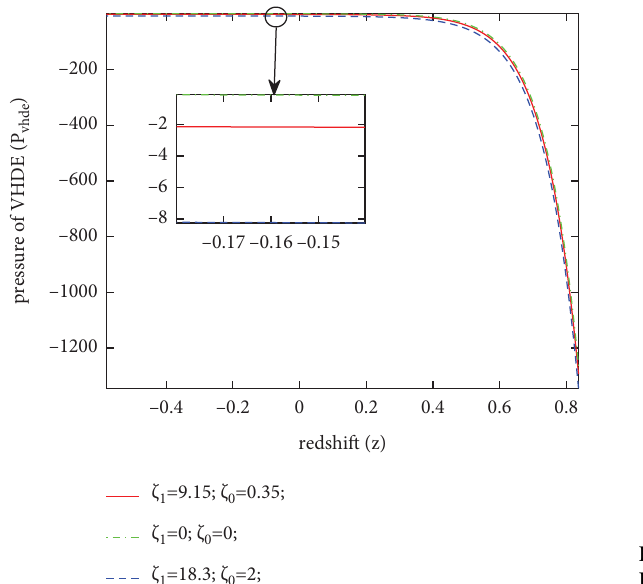
Figure 2: Pressure of VHDE ( P